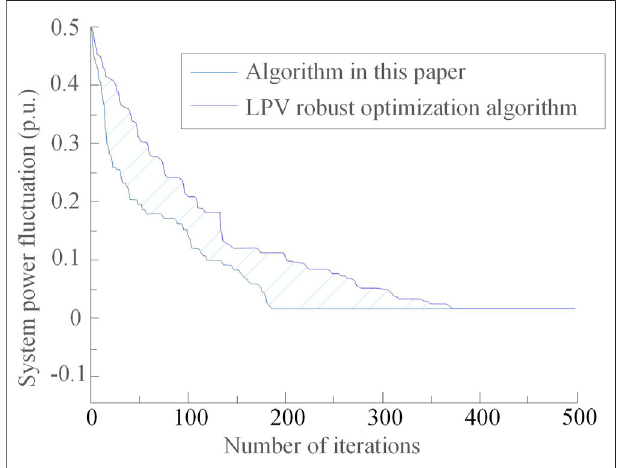
FIGURE 8 | The distribution plane of the optimal solution of the lower- layer model.